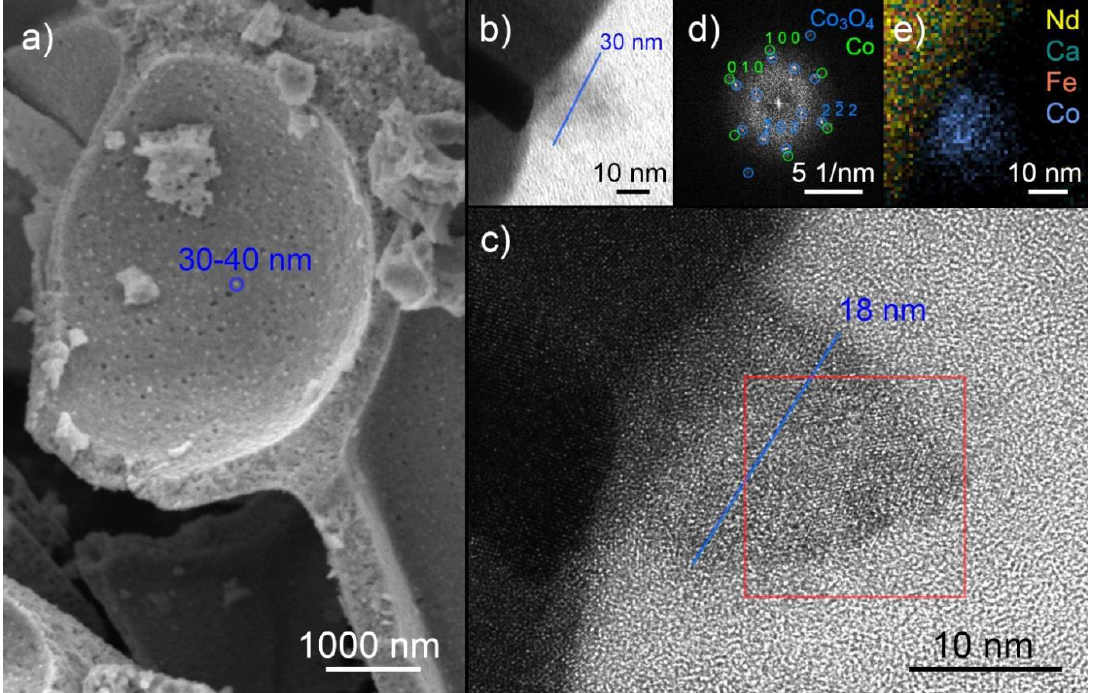
Figure 5. SEM, (HR)TEM, and EDX images of the Co doped perovskite. SEM ( a ) displays small well-distributed nanoparticles after reduction in humidified H 2 (ratio H 2 :H 2 O ≈ 32:1, p = 1 bar) at 848 K. TEM ( b ) and HR-TEM ( c ) after reduction in humidified H 2 (2.5% H 2 /2.5% H 2 O/balance Ar) at 923 K and exposure to air reveal a core shell structure of these nanoparticles with visible lattice planes. The FFT image ( d ) of the part of the particle marked with a red frame shows the presence of Co 3 O 4 (shell), zone axis [121], and weaker signals of a Co phase (core), zone axis [001]. EDX ( e ) confirms that Co is the predominant metal in the nanoparticle.